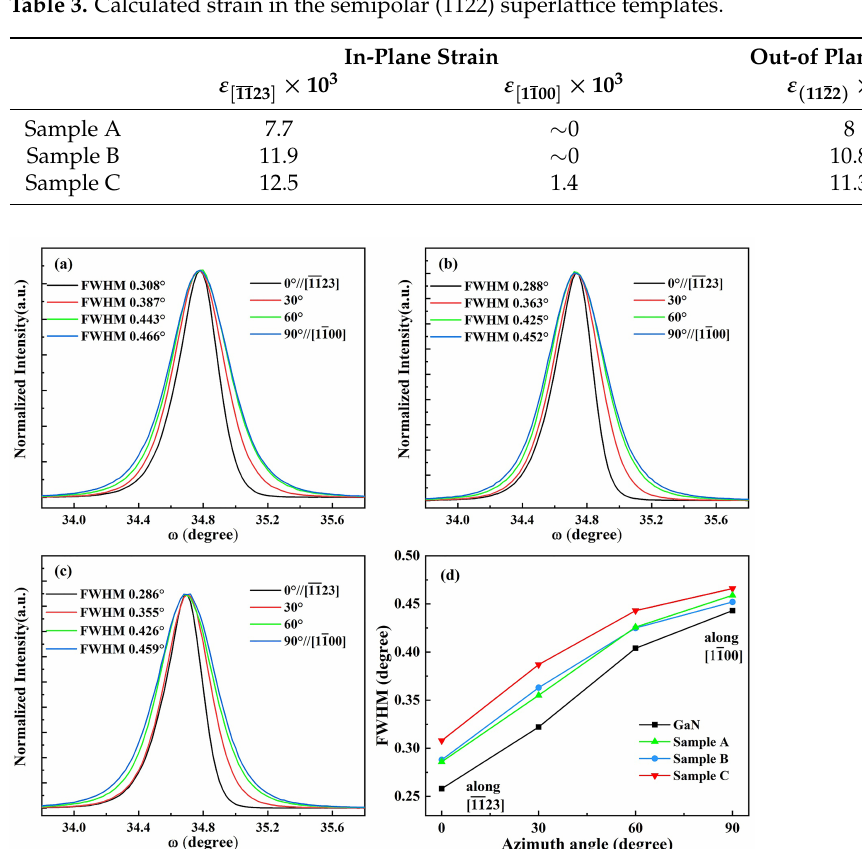
Figure 4. The XRC results of the (1122) GaN with respect to different azimuthal angles in different superlattice structures: ( a ) Sample A; ( b ) Sample B; ( c ) Sample C; ( d ) the variation trend of FWHM for different